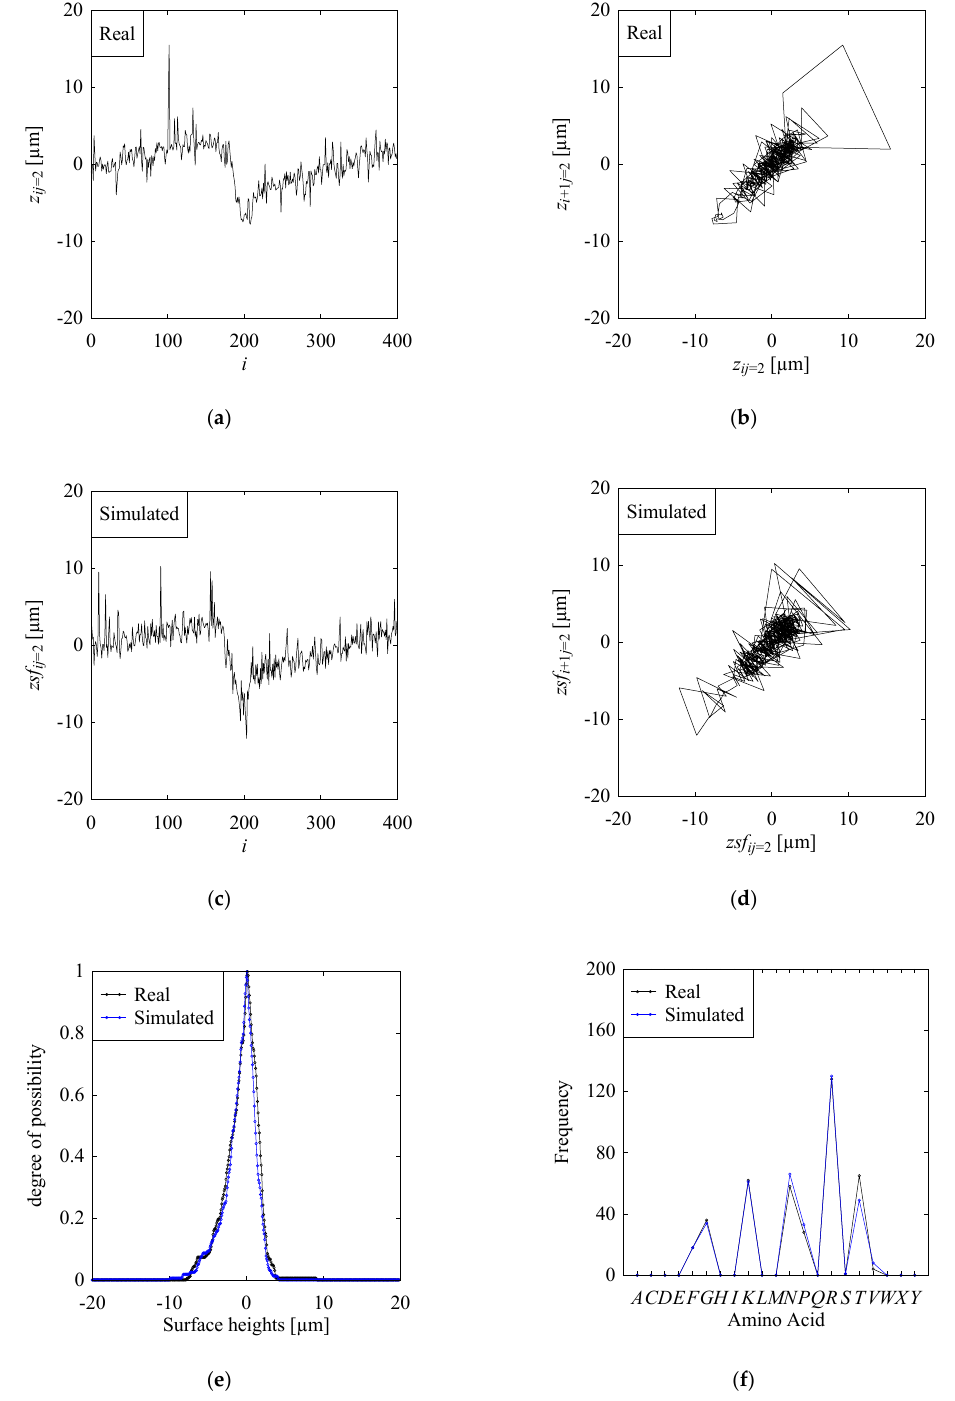
Figure A2. Outcomes of SC and VC corresponding to the semantic modeling-based MC for z ij =2 : ( a ) real surface heights; ( b ) return map of ( a ); ( c ) simulated surface heights; ( d ) return map of ( c ); ( e ) possibility distribution; ( f ) DNA-based computing.